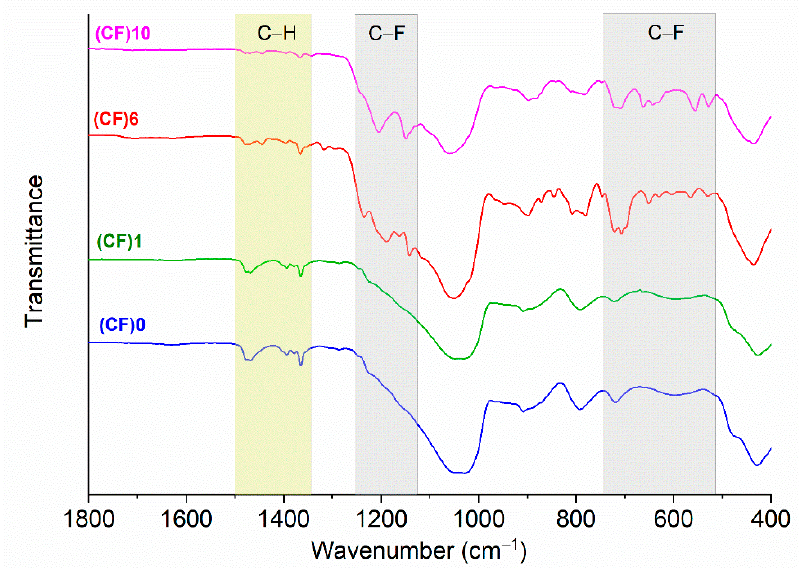
Figure 1. FTIR spectra of all coatings deposited on PET foil. Table 1. Main bands or band range with corresponding bond vibration in FTIR spectra.